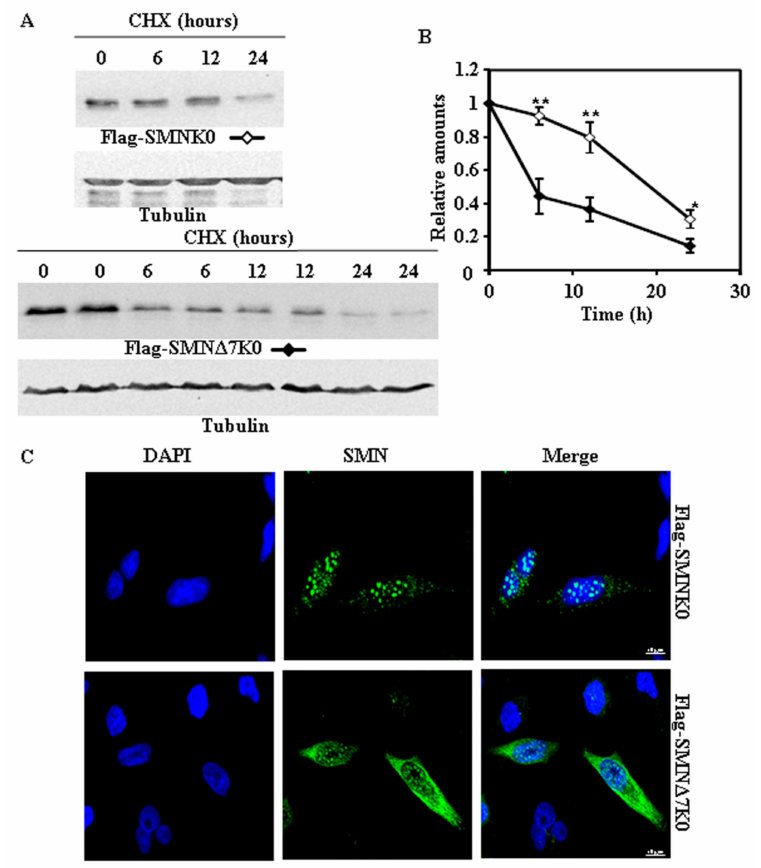
Figure 4. Degradation and subcellular localization of ectopically expressed Flag-SMNK0 and Flag-SMN ∆ 7K0 in HeLa cells. ( A ) HeLa cells were transiently transfected with SMNK0 or SMN ∆ 7K0 (replicates are shown for each time point) tagged at the N-terminus with Flag and treated with CHX for the indicated times. Total cell lysates were analyzed by Western and immunoblot with anti-Flag specific antibodies. Anti-tubulin antibodies were used as total protein loading control. ( B ) Graph of the quantification of the corresponding immunoblots. ( C ) Confocal fluorescence images of HeLa cells transfected with Flag-SMNK0 and Flag-SMN ∆ 7K0, stained with anti-FLAG specific antibodies (green channel) and counterstained for nuclei with DAPI (blue channel). Bars = 10 µ m. Values are expressed as mean ± S.E.M. from three different experiments. Asterisks indicate a statistical significant difference between pairs (* p < 0.05, ** p < 0.01, Student’s t -test). n.s., not